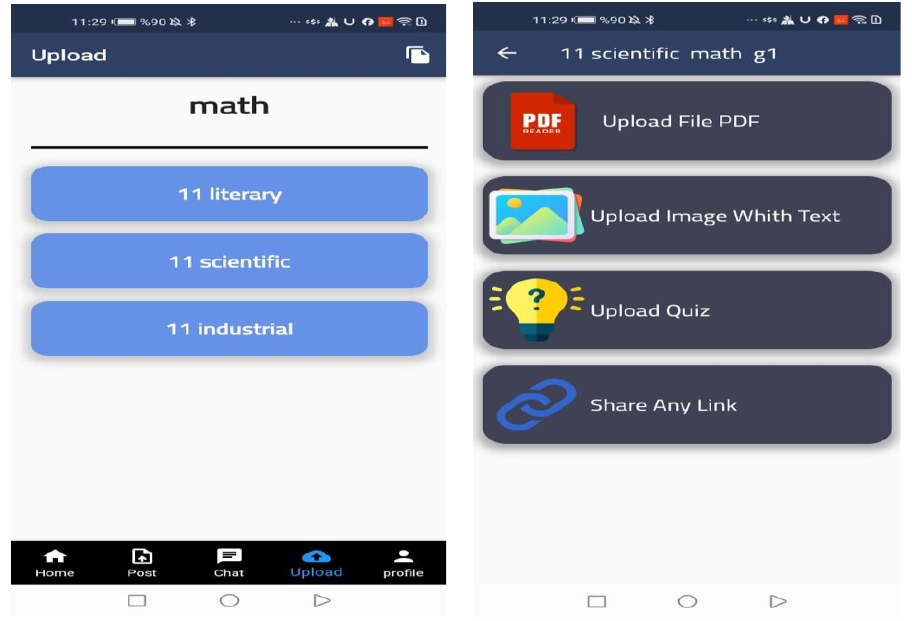
Figure 9. The screen of upload.